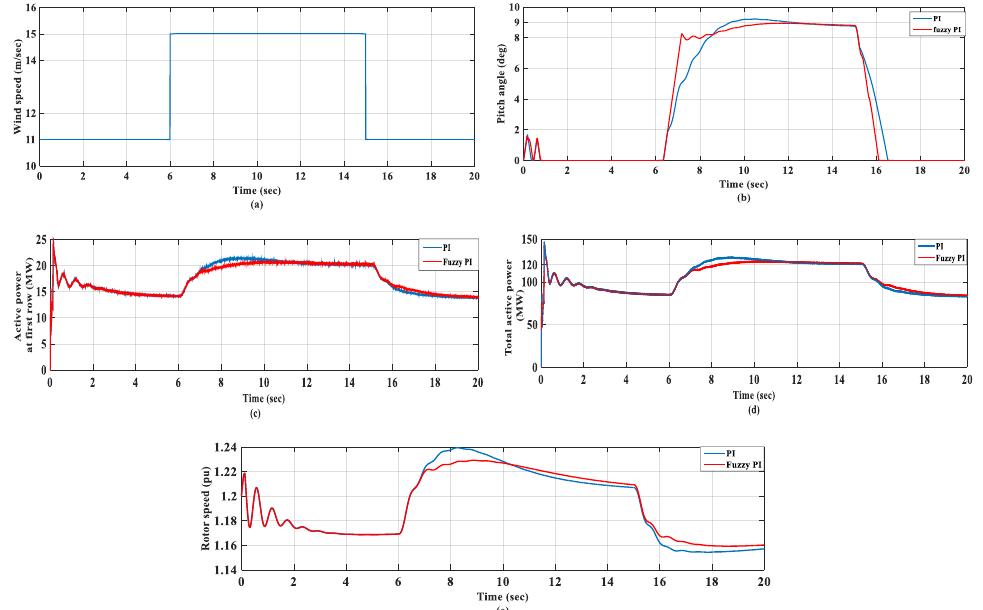
Figure 11. System response during step wind speed: ( a ) wind speed, ( b ) pitch angle, ( c ) active power of first row, ( d ) total active power, ( e ) rotor speed.